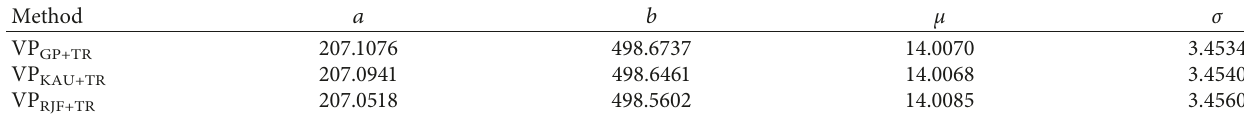
Table 3: Parameter results.